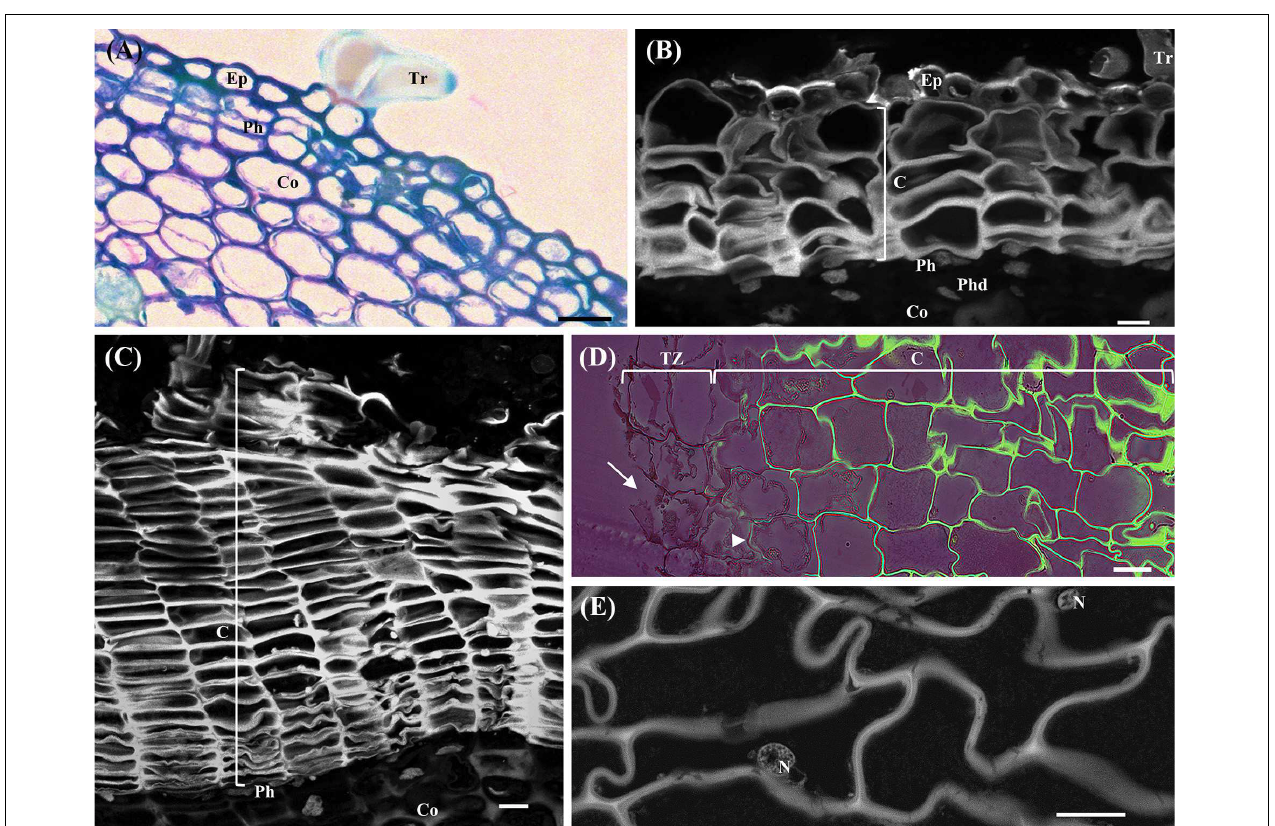
FIGURE 1 | Anatomical analysis of cross-sections of young sprigs (herbaceous, and one and three-year-old sprigs) and traumatic periderms. (A) Toluidine Blue O staining of the herbaceous sprigs showing the epidermis with pluricellular trichomes, cortical parenchyma, and the first periclinal divisions originating the precursor of the phellogen. (B) Autofluorescence detection under UV light of cork cells and residues of the epidermis with trichomes in cross-sections of one-year-old sprigs. Right below the cork cells is the phellogen, and the underlying tissues phelloderm and cortical parenchyma. (C) Autofluorescence detection under UV light of several cork cell layers resulting from the phellogen activity in cross-sections of three-year-old sprigs. (D) Berberine/crystal violet staining of traumatic periderms observed under UV light. The cells from the tear zone presented disrupted cellulosic reddish walls (arrows). The contiguous layer of cork cells already shows suberized walls at early stages of differentiation (arrowhead), and highly suberized walls at later stages of differentiation (intense green). (E) Cells at later stages of cork differentiation showing entire nuclei. DNA was counterstained with DAPI. Bar = 10 µ m. Ep, epidermis; Tr, pluricellular trichomes; Co, cortex; Ph, phellogen; C, cork cells; Phd, Phelloderm; Tz, tear zone; N,